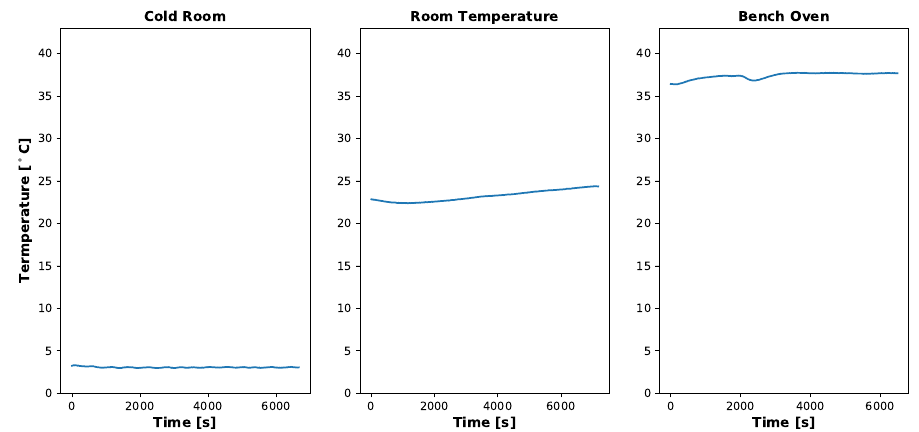
Figure 8. Temporal temperature profile during MicaSense RedEdge-3 dark current testing. Temperature inside the light tight bag did not change significantly during the course of the test. Data collection took about 2 h for each temperature environment because the gain and exposure time had to be changed manually in-between image